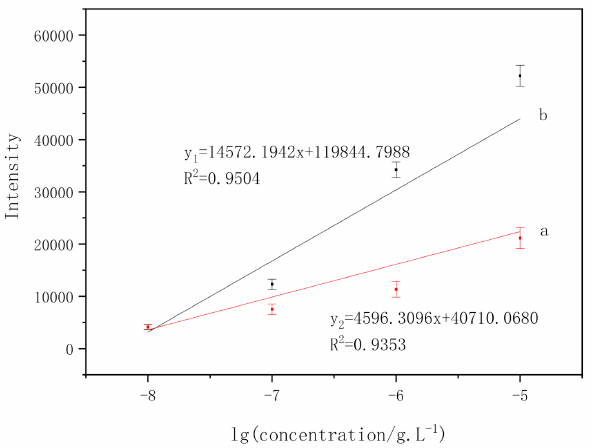
Figure 11. Linear relationships between the pyrene characteristic intensity and the logarithm of pyrene concentration. (a) 1016 cm − 1 ; (b) 590 cm − 1